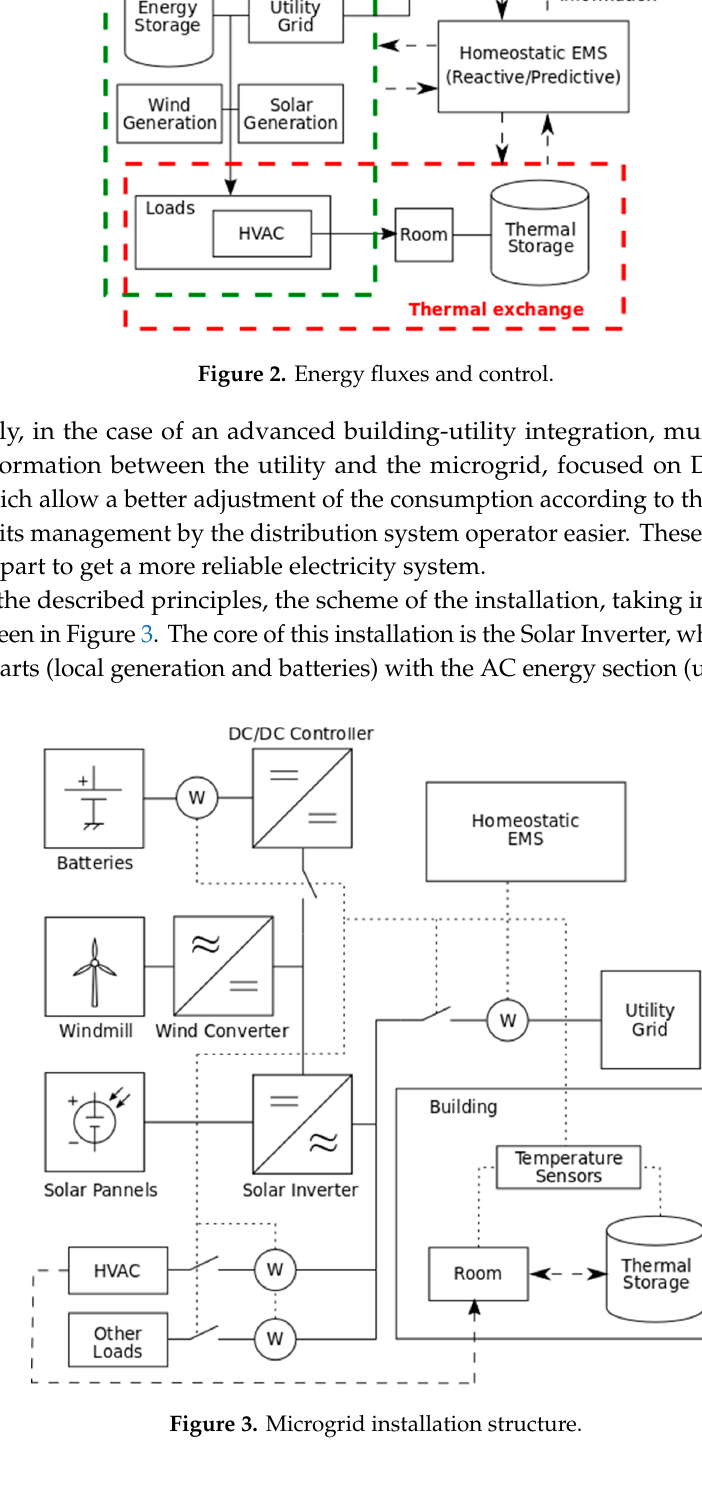
Figure 3. Microgrid installation structure.